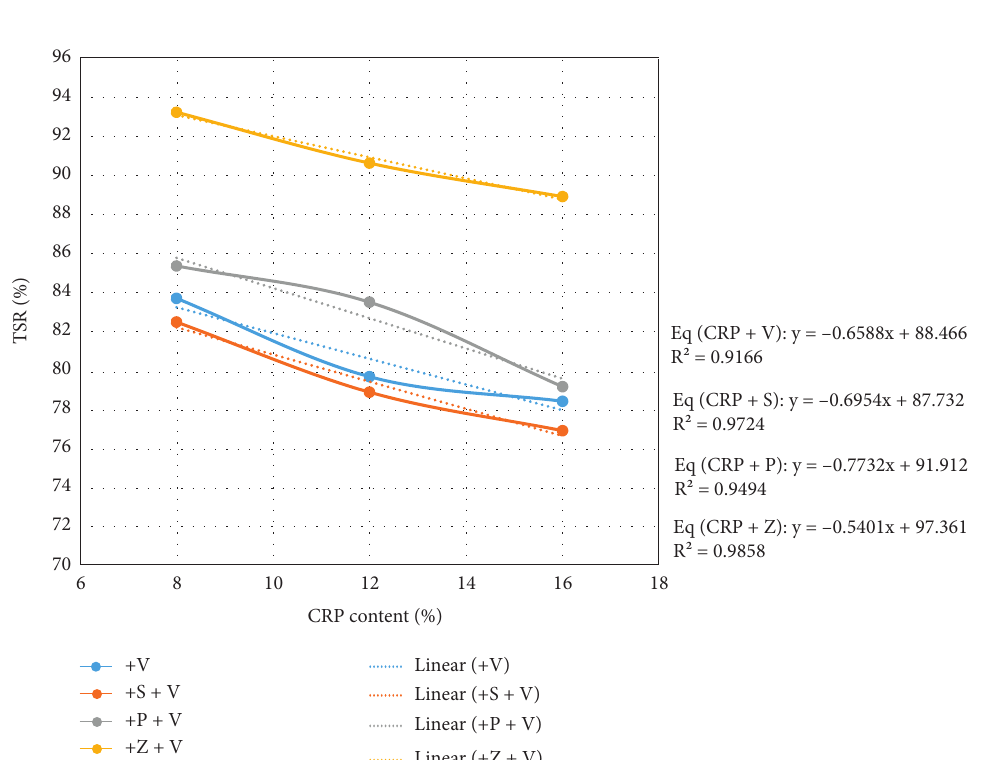
Figure 7: TSR variations in different CRP contents for various